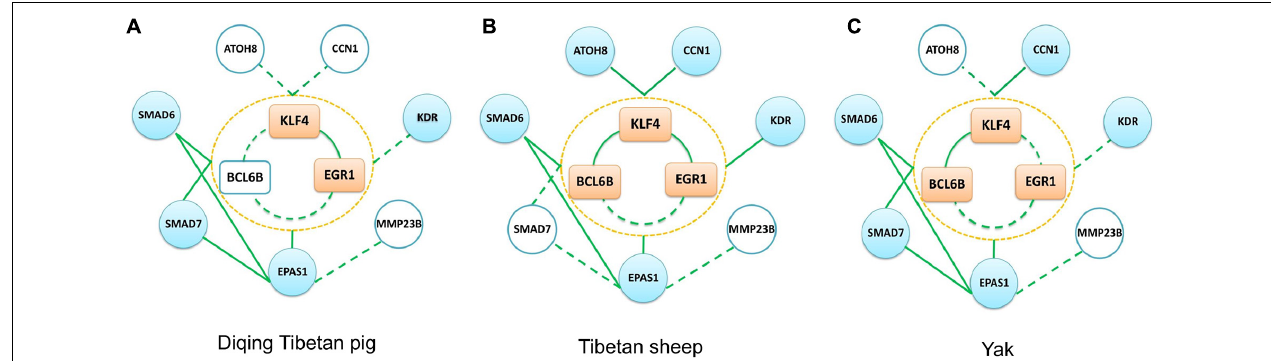
FIGURE 8 | Three other groups (Diqing Tibetan pig, Tibetan sheep, and yak) verification network. (A–C) The verification results of the Diqing Tibetan pig, Tibetan sheep, and yak, respectively. The peach-colored rectangle in the middle part of each subgraph represents the KLF4–EGR1–BCL6B complex, the sky blue circle represents the target gene, and the white circle represents that this gene is not included in the data set. The solid green line in the figure represents the edge we verified, and the dotted line represents the unverified edge.